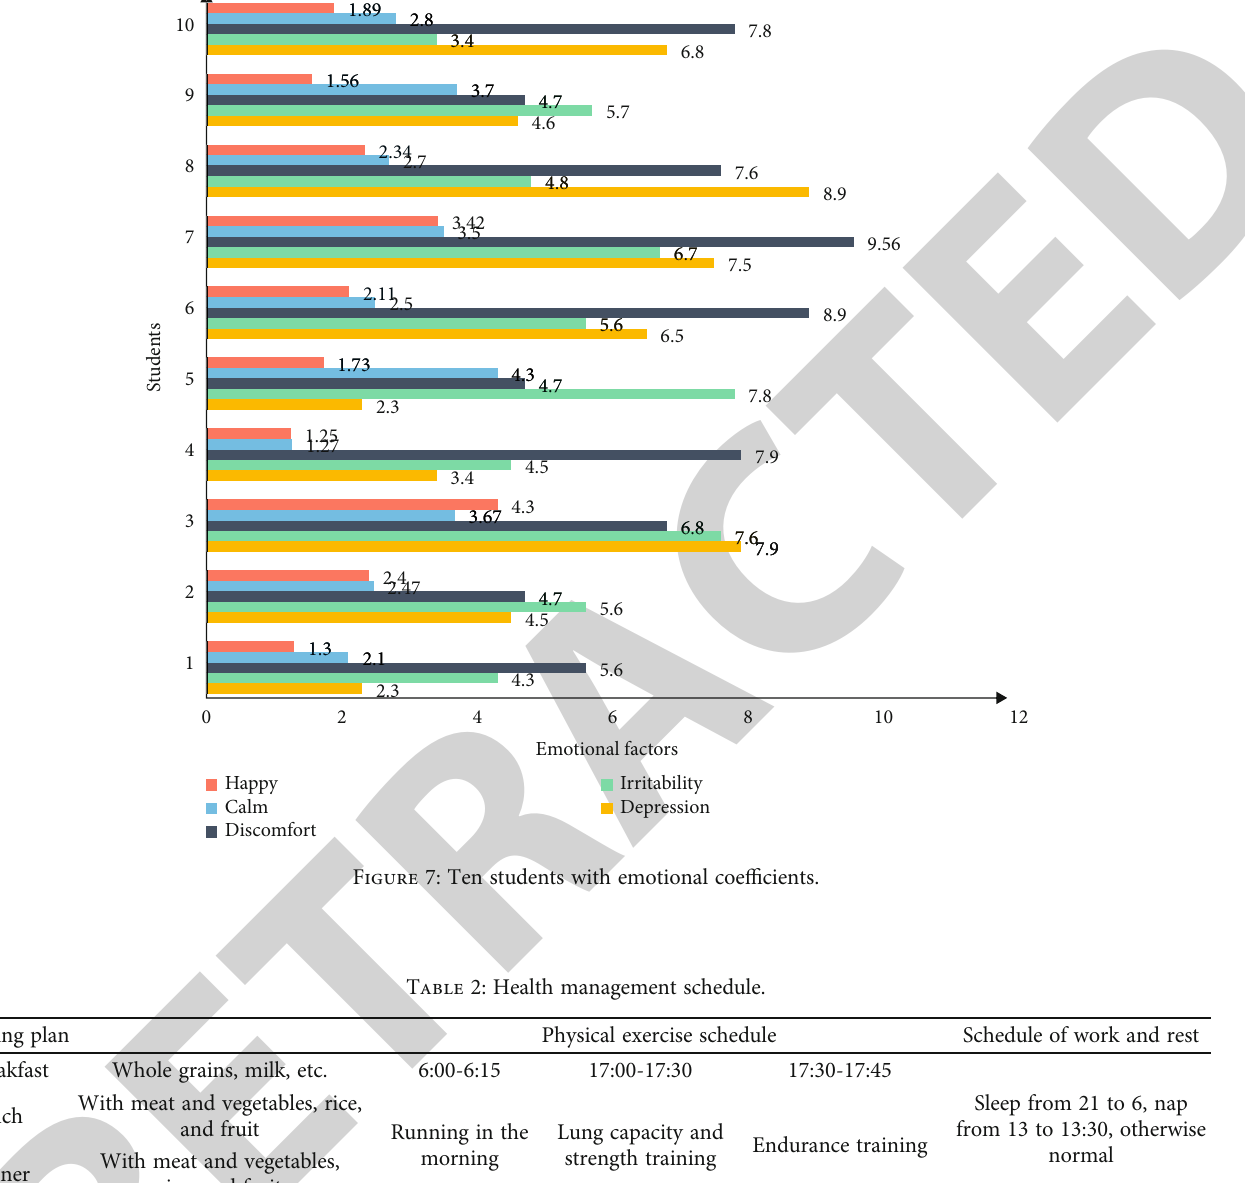
Figure 7: Ten students with emotional coe ffi cients.